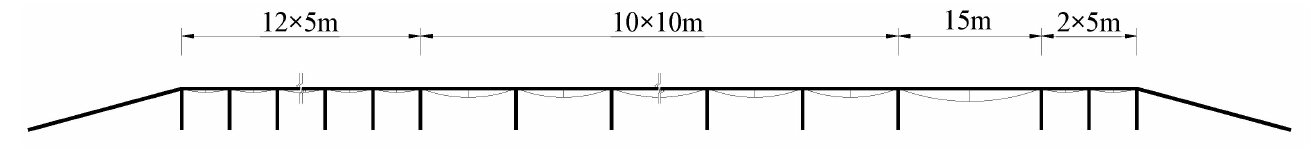
Figure 3. General layout of the AERORail test